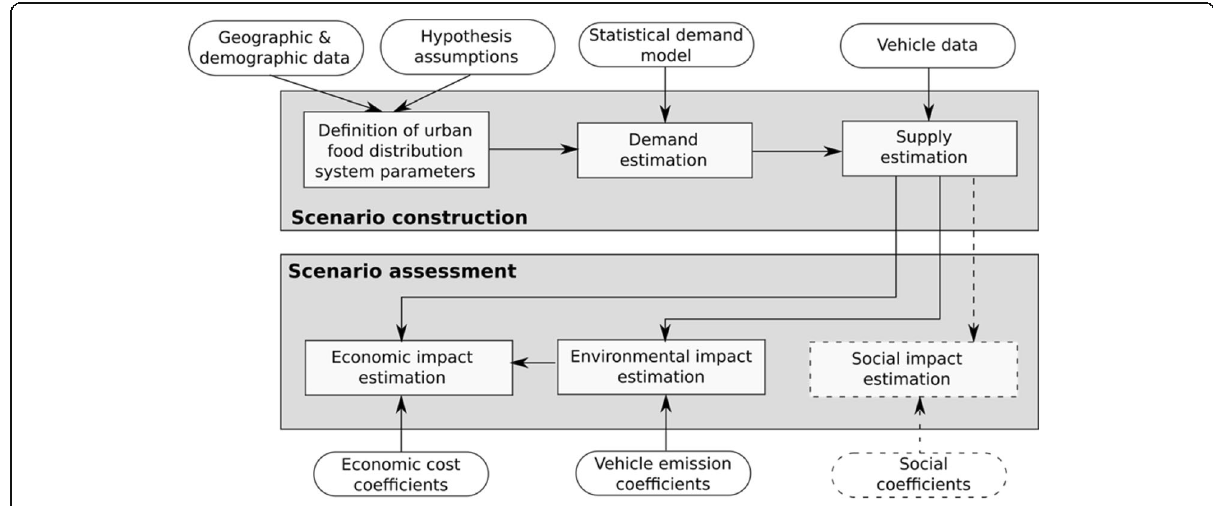
Fig. 1 Chart of the proposed